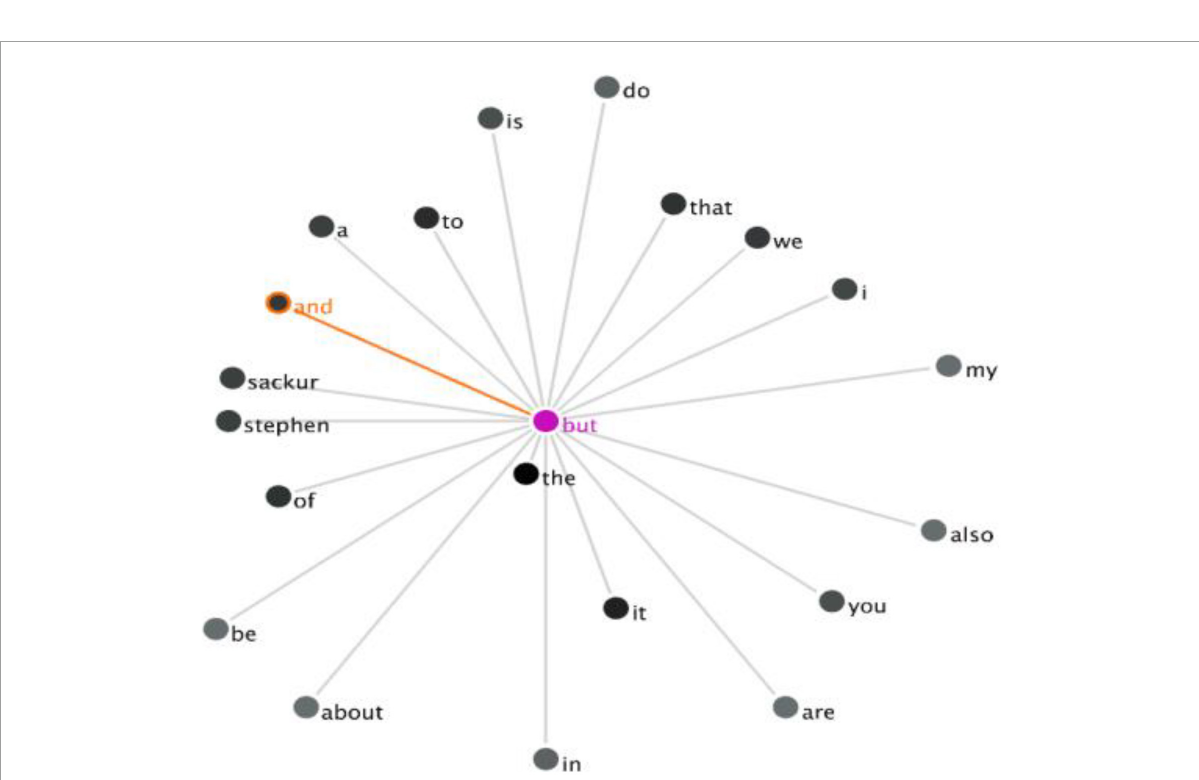
FIGURE4 The GraphColl of the co-occurrence of “and but” in the UK